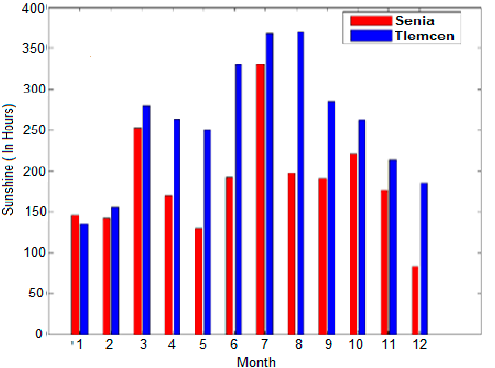
Figure 3. Distribution of Monthly sunshine durations for Tlemcen and Senia.